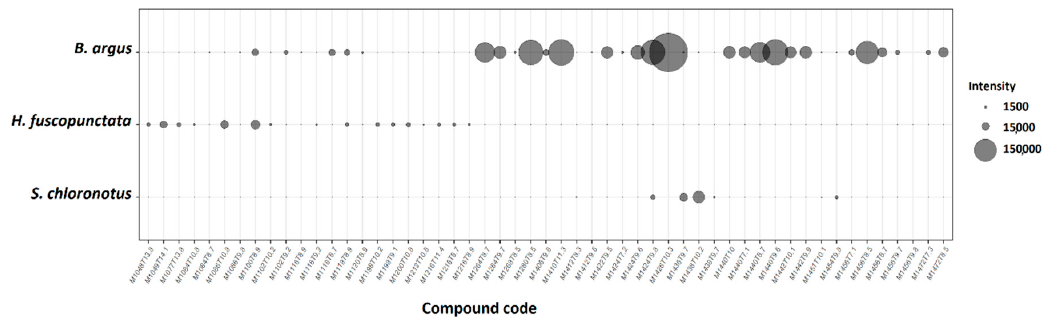
Figure 8. Major saponin compounds detected in the butanol fractions from the crude extracts of the three most active sea cucumber species (peak area ≥ 10 3 ). Compound code represent the exact mass (M in Da), and retention time (T in min). The compounds code of M1426T10.3 related to bivittoside D , and M1410T11.3 related to bivittoside C .